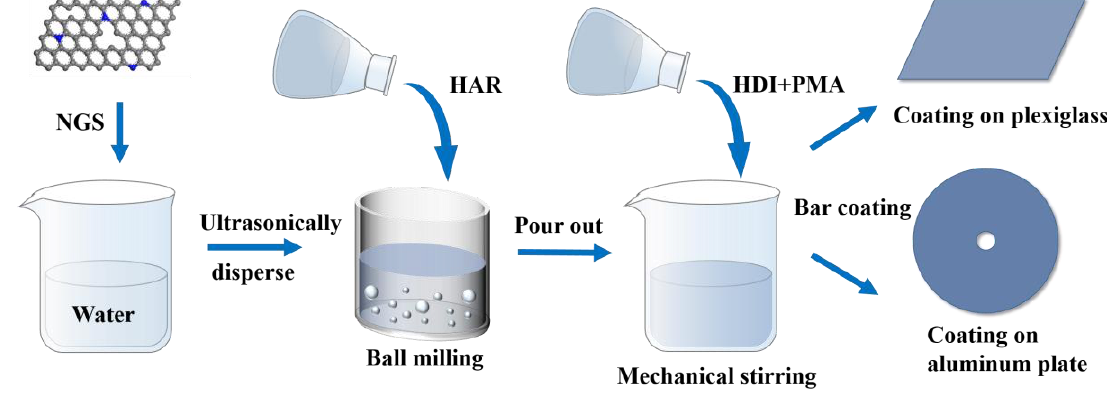
Figure 1. Schematic diagram about the preparation route for NGS/WPU composite coatings.